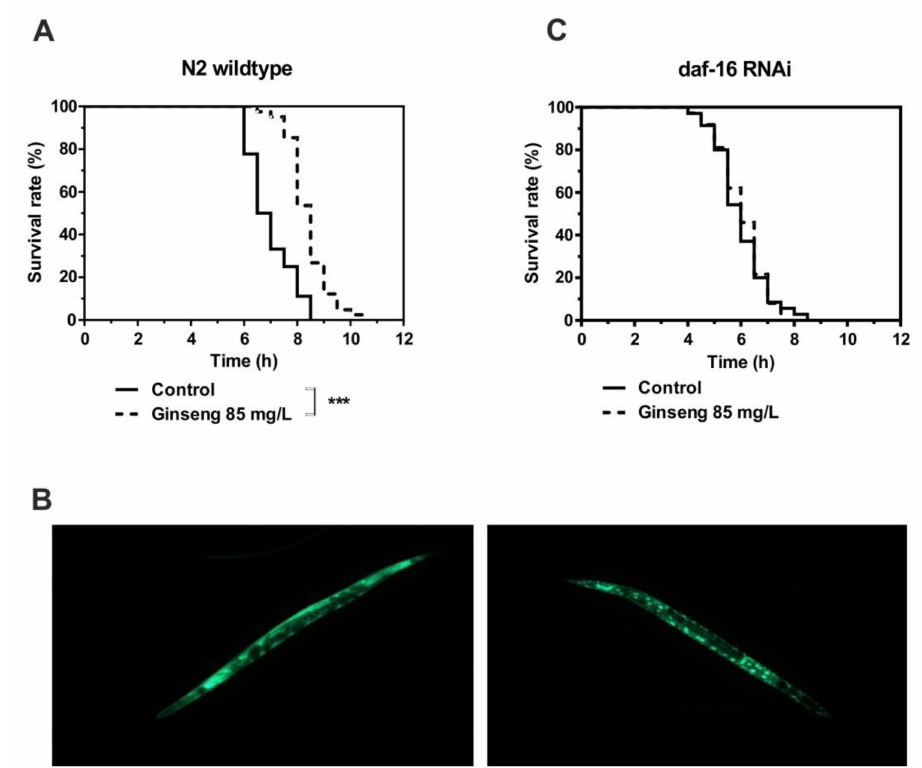
Figure 5. The survival time of N2 wildtype C. elegans at 37 ◦ C in the absence (control) or presence of 85 mg / L ginseng extract was measured as described in the Methods section ( A , C ). Representative image of daf-16::GFP in strain TJ356 ( B ). *** p < 0.001 indicates significant di ff erences from the